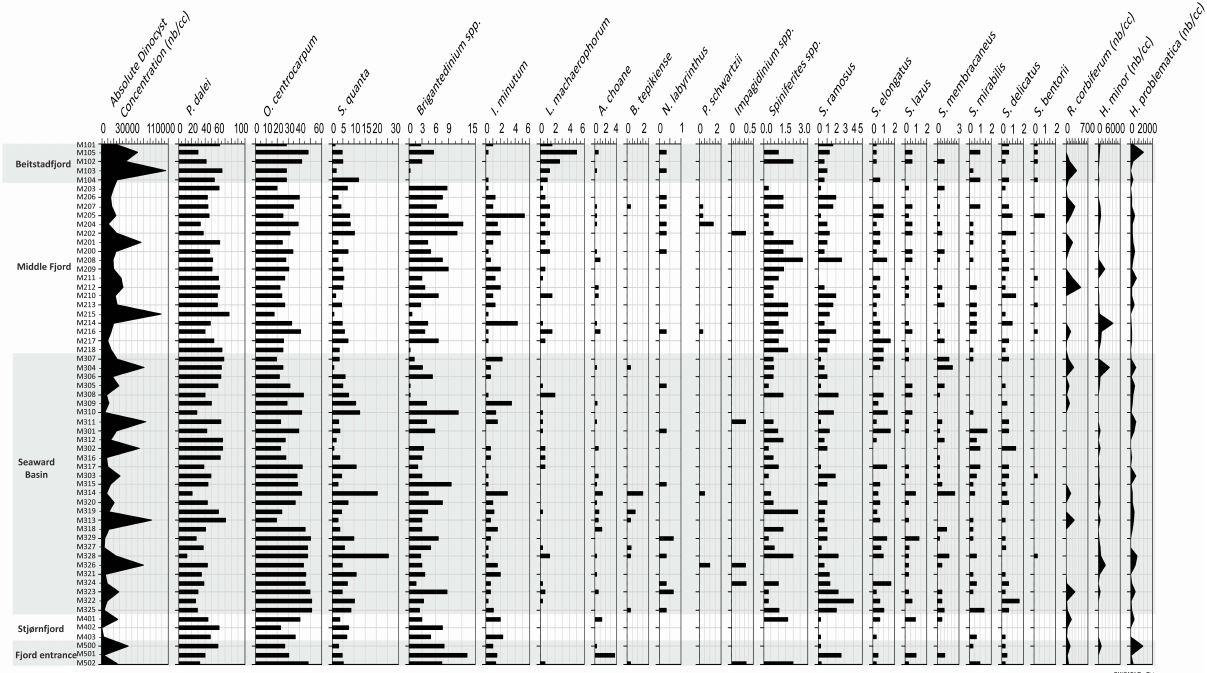
Fig. 5. Dinocyst assemblages in the Trondheimsfjord; relative abundances of cysts are given in %, total abundance of cysts per sample and other palynomorphs are displayed as concentration in cystscm − 3 .